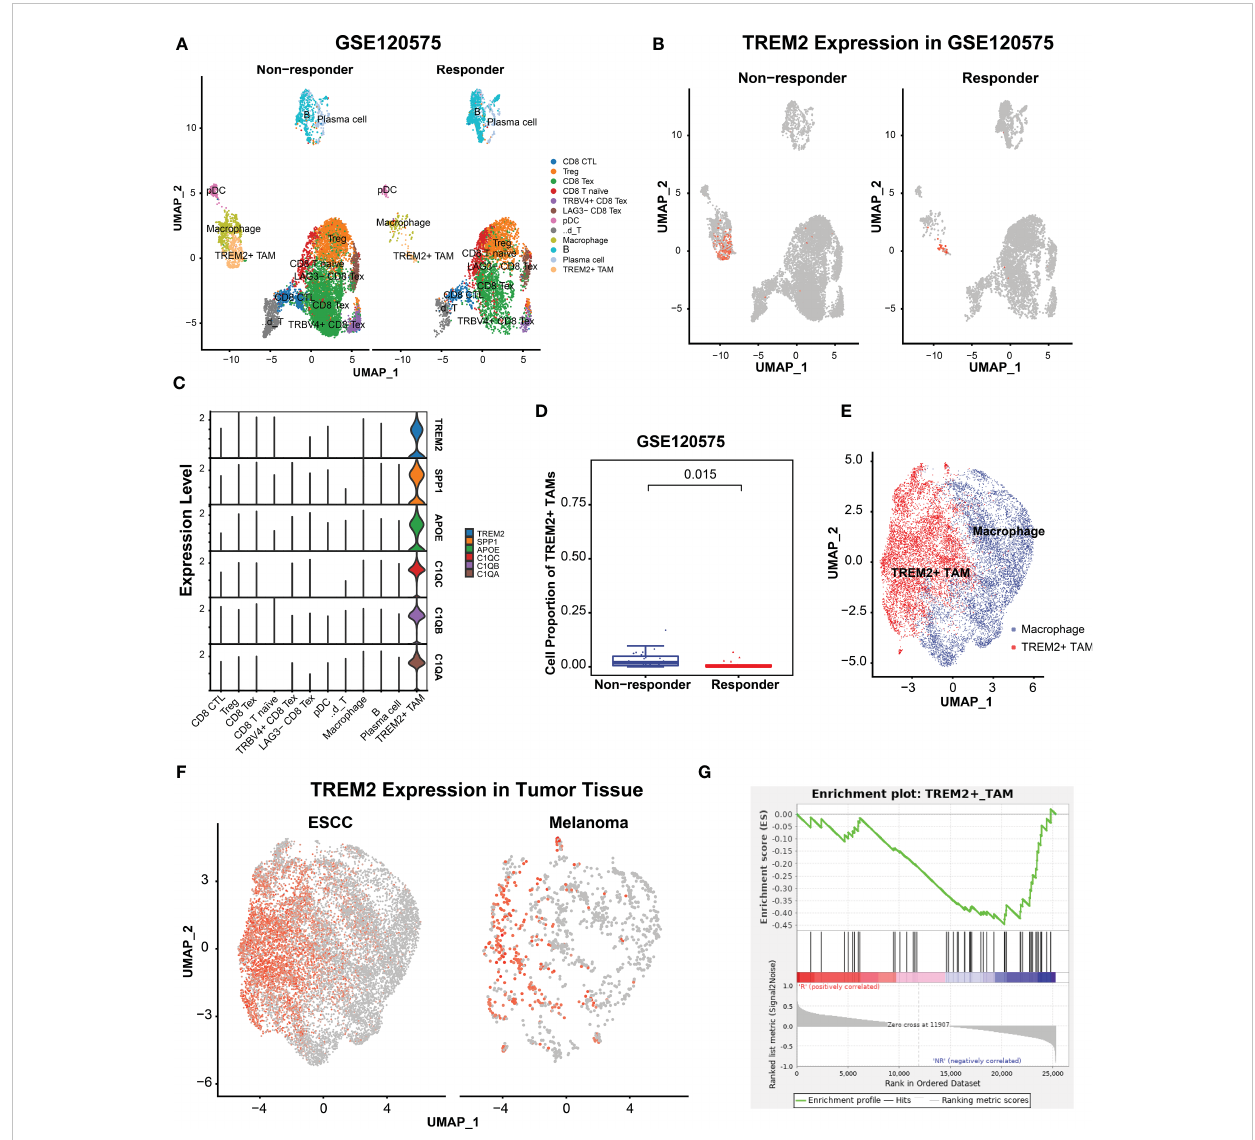
FIGURE 4 TRME2 + TAMs enriched in melanomas with no response to immunotherapy. (A) UMAP plot of cells colored by cell types and splitted by responder and non-responder using GSE120575. (B) UMAP plot of cells colored by expression level of TREM2 . (C) Violin plot showing expression level of APOE , SPP1 , TREM2 , C1QA , C1QC , and C1QB among 12 cell types. (D) Boxplot showing cell proportion of TREM2 + TAMs between responder and non- responder. Wilcoxon test was used. (E) UMAP plot of macrophages from ESCC and melanoma. Red dots indicate TREM2 + TAMs, Other dots indicate the rest macrophages. (F) UMAP plot of macrophages colored by TREM2 expression level and splitted by ESCC and melanoma. (G) Gene set enrich analysis on the RNA-seq pro fi les of 25 melanoma patients treated with anti-PD1 immunotherapy. R represented response to anti-PD1, NR represented no